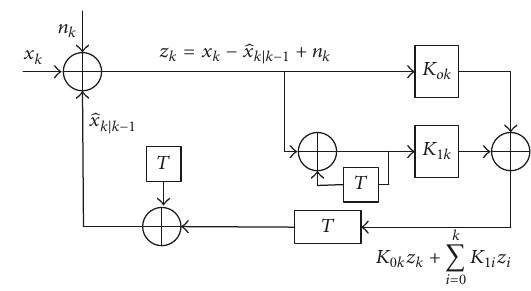
Figure 4: DPLL structure block diagram.